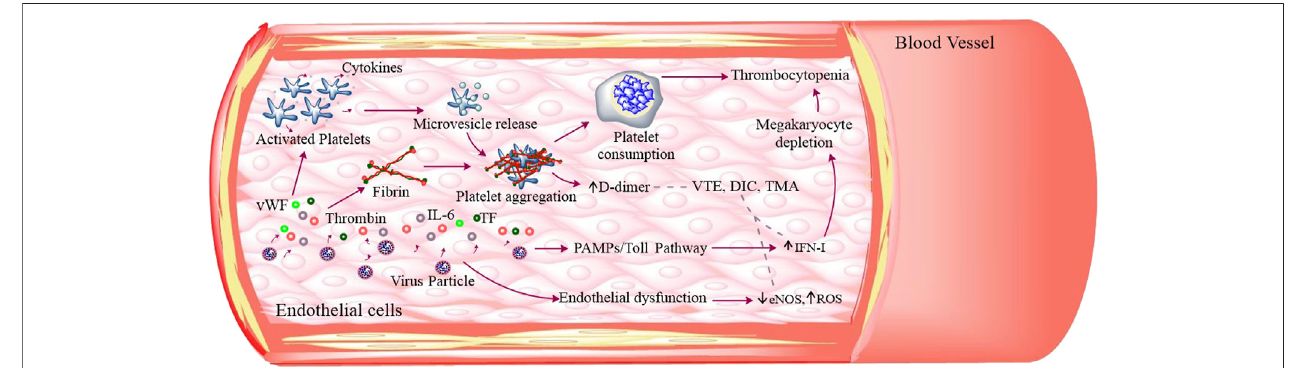
FIGURE 4 | SARS-CoV-2 – induced thromboses and platelet dysfunction: SARS-CoV-2 infection caused endothelial dysfunction that releases ROS, IL-6, TF, and vWF.Thesemoleculesalongwiththrombincanactivate platelets. Theactivated platelets adhere, aggregate, and secrete itsgranular( α and densegranules)contentsas well as extracellular vesicles. The aggregated platelets induce high platelet consumption and IFN-I through Toll pathway inhibiting magakaryocyte to produce platelets, thus leading to low platelet production. All these cumulatively results in thrombocytopenia. The fi brinogen degradation produces D-dimer and other thrombogenic molecules that result in venous thromboembolism (VTE), disseminated intravascular coagulation (DIC), and thrombotic microangiopathy